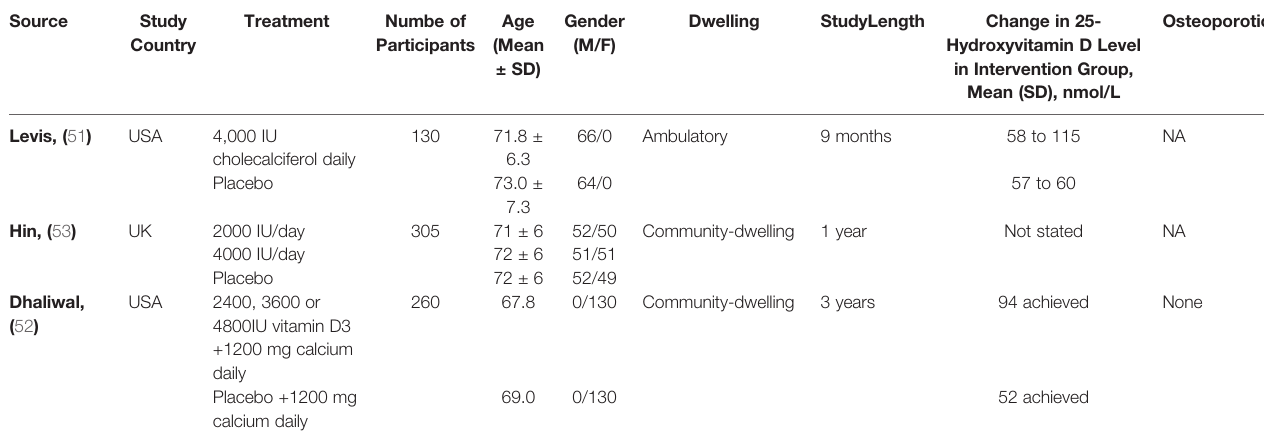
Pooled primary analysis of the eighteen